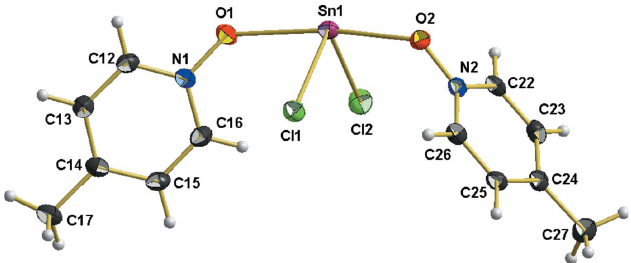
Figure 2 The asymmetric unit of SnCl 2 (cid:2) 2MePyNO, 2 , with the atom-numbering scheme; with exception of the hydrogen atoms (which are shown as spheres with arbitrary radius) all atoms are drawn with displacement ellipsoids at the 40% probability level.